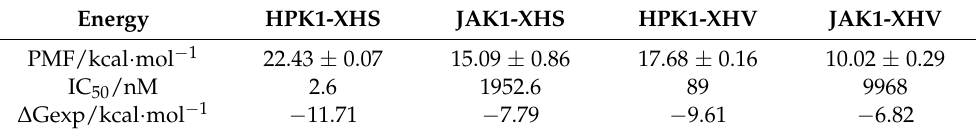
Table 4. PMFs of the inhibitor unbinding from the ATP pocket based on the US simulations.